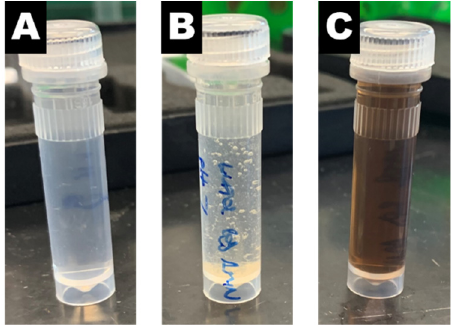
Figure 3. The effect of pH condensation of benzaldehyde with 4-aminophenol. ( A ) Reaction solution pH of 4 with no color change or precipitate observed. ( B ) Reaction solution pH of 7 with a precipitate observed. ( C ) Reaction solution pH of 10 with a brown color changed observed and no precipitate.